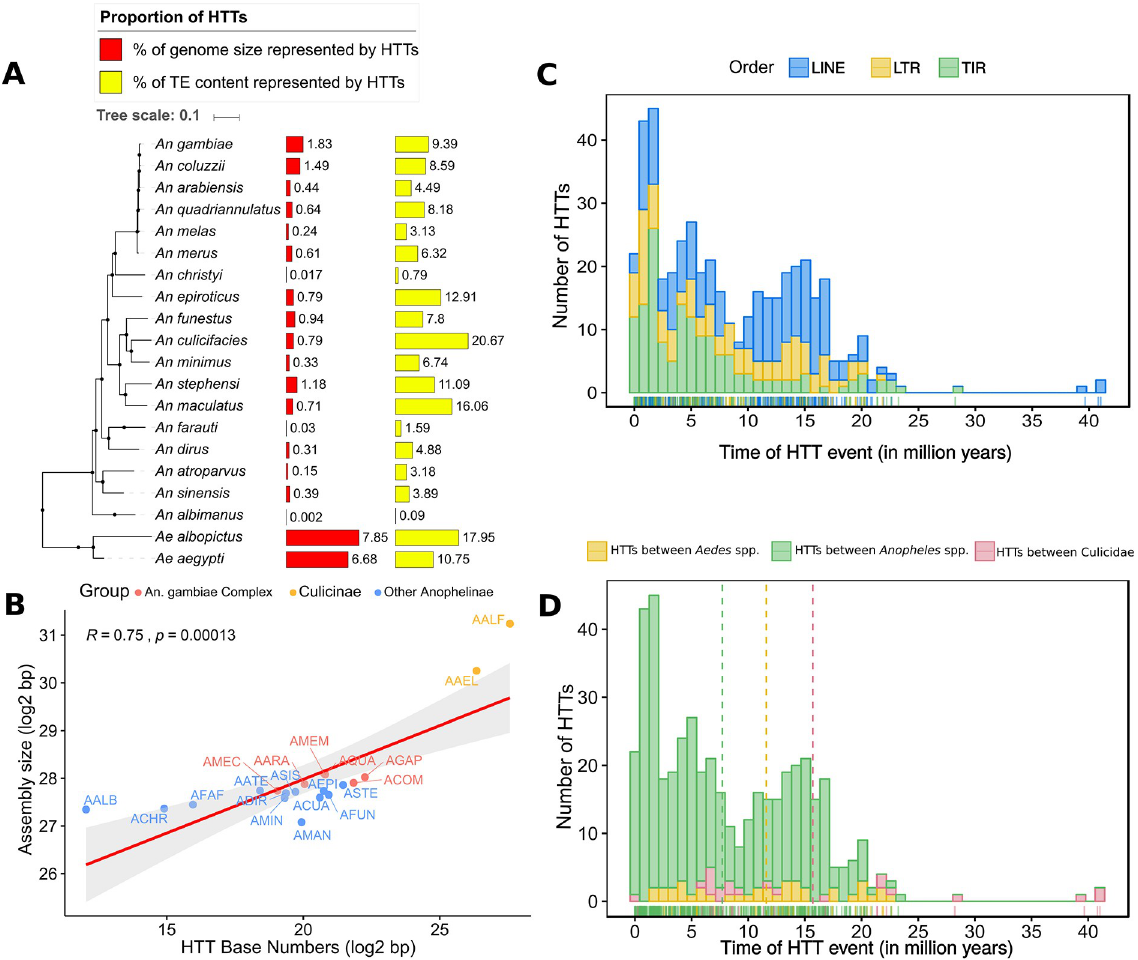
Fig 4. Influence of HTT on the host genome and dating. (A) The proportion of the host genomes composed of TEs involved in HT. (B) The correlation between the number of nucleotides covered by TEs involved in HTT events and genome size of mosquitoes. The age of each pairwise HTT event is estimated and represented by TE groups (C) and host taxa